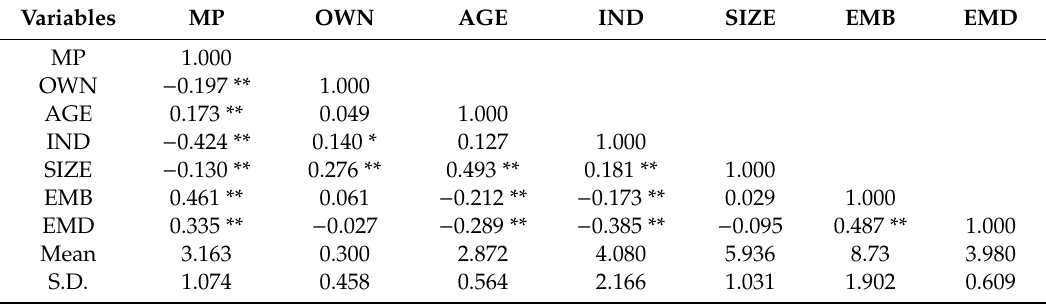
Table 2. Descriptive statistics and correlation